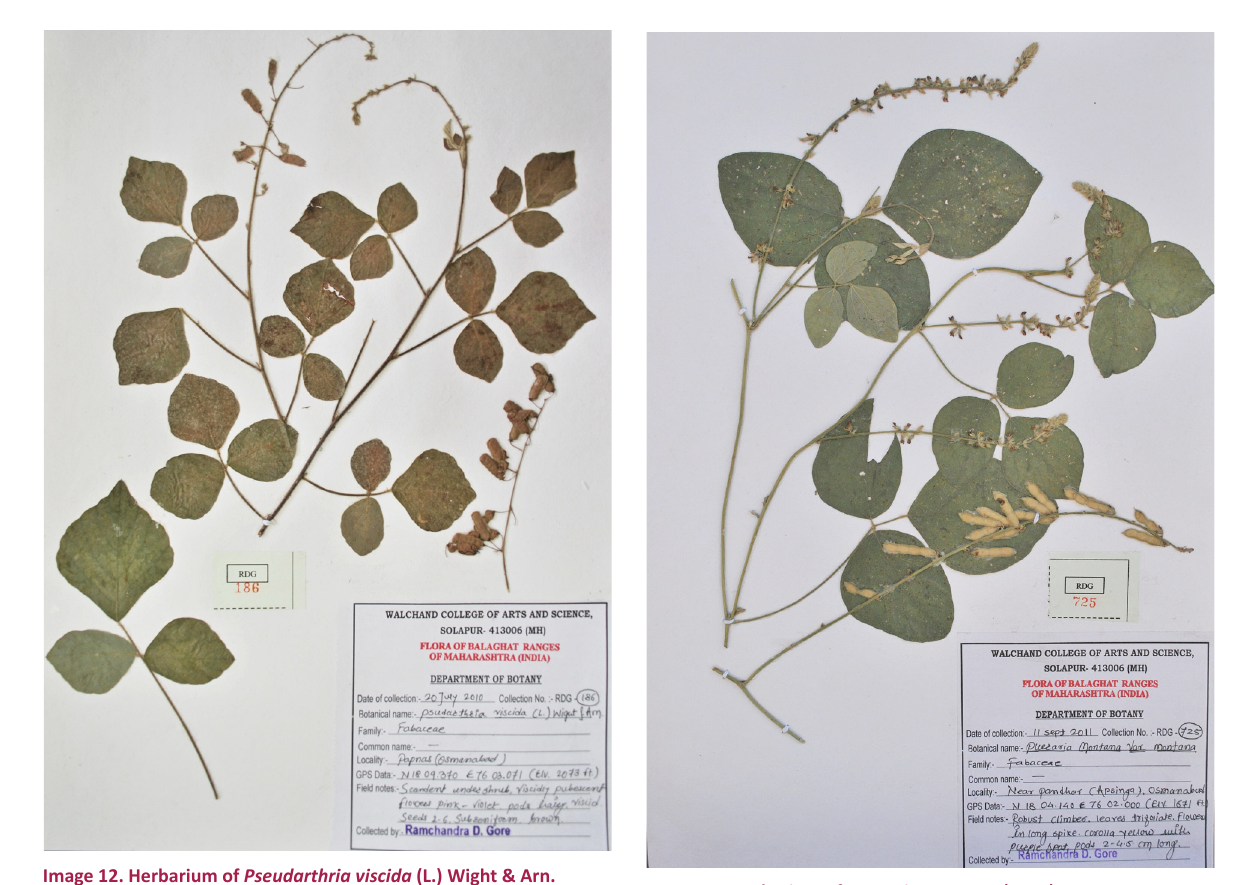
Image 14. Herbarium of Pueraria montana (Lour.)